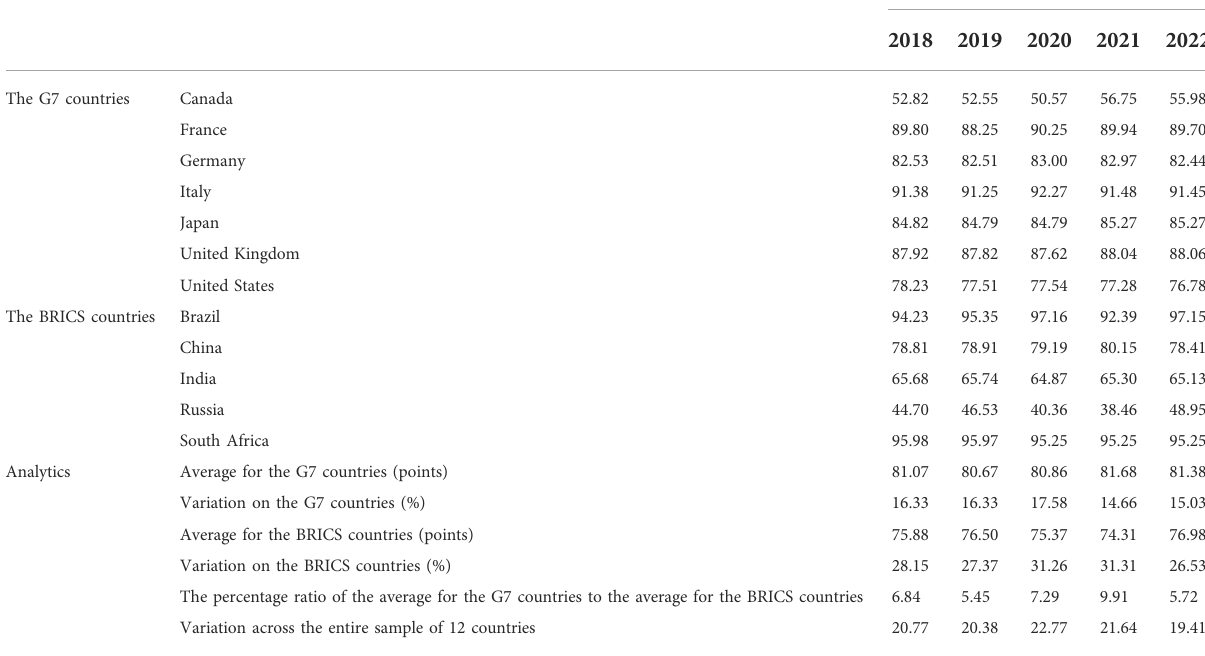
TABLE 1 Climate index in the G7 and the BRICS countries in 2018 –